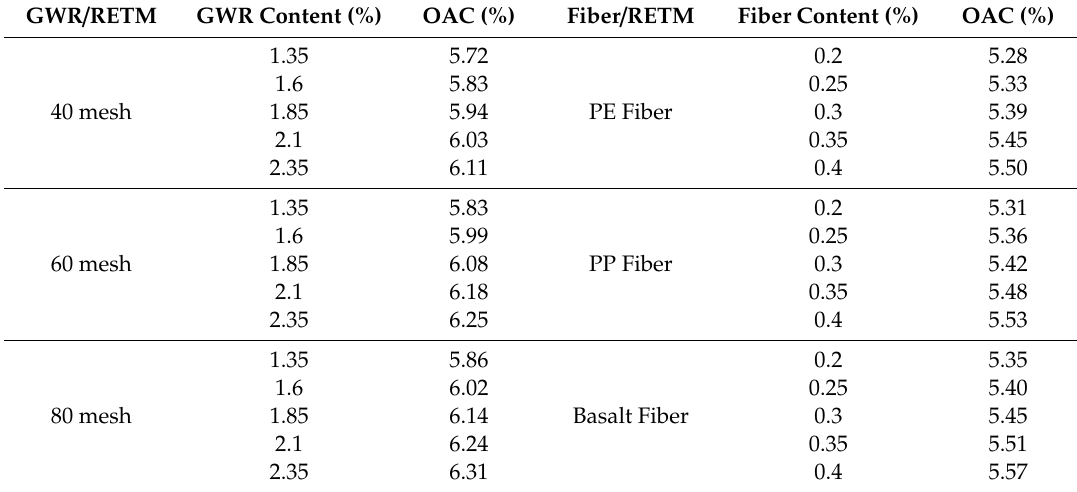
Table 8. Optimum asphalt contents of asphalt mixtures in this